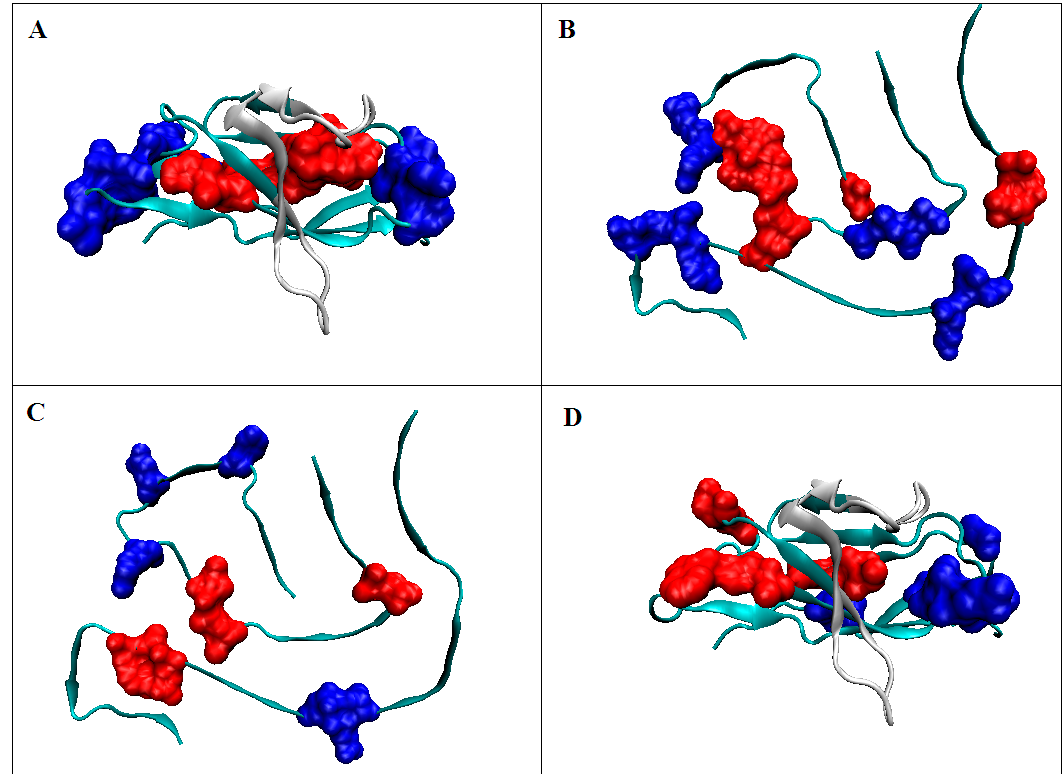
Figure 6. 3D presentation of structures: ( A ) IgG light chain V domain with red residues forming the hydrophobic core; blue indicates residues with low hydrophobicity, as expected, located on the surface. Criteria of identification according to Figure 5A; ( B ) amyloid C chain (6HUD) with distinguished residues making up the hydrophobic core of the V domain (as in Figure 5A); ( C ) amyloid C chain (6HUD) with distinguished residues making up the hydrophobic core according to the hydrophobicity distribution in this chain (Figure 5B); ( D ) IgG light chain V domain with residues differentiated according to the profiles shown in Figure 5B. Red—residues belonging to hydrophobic core, blue – residues on surface with low hydrophobicity level—both selections accordant with the fuzzy oil drop model